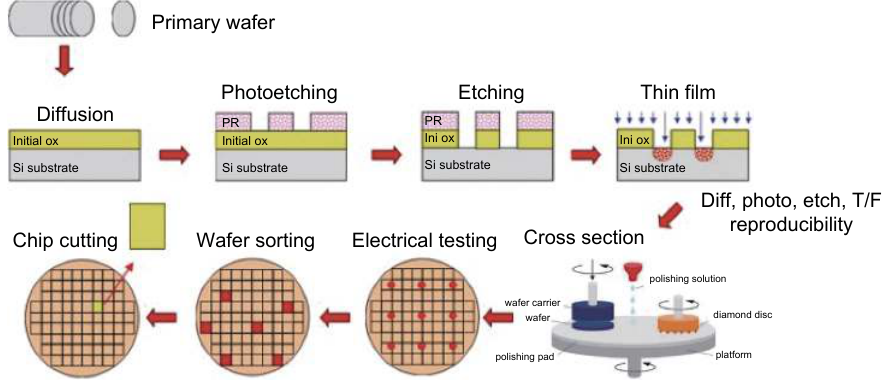
Fig. 1 Workflow of semiconductor